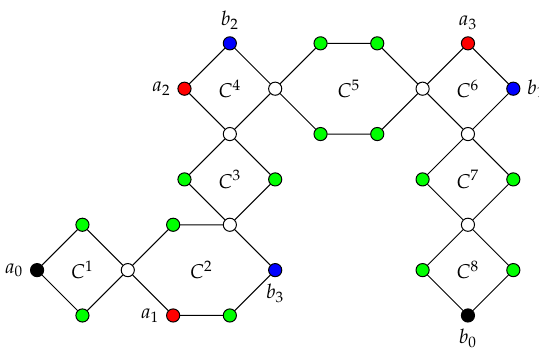
Figure 4. A chain of cycles F ∈ F 3 containing six cycles C 4 and two cycles C 6 .